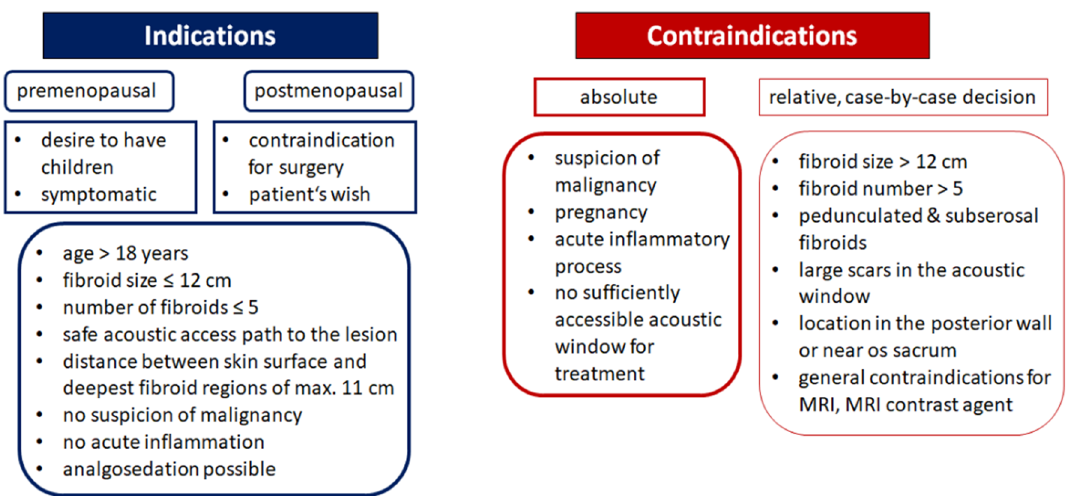
Figure 2. Indication and contraindication for HIFU treatment of uterine